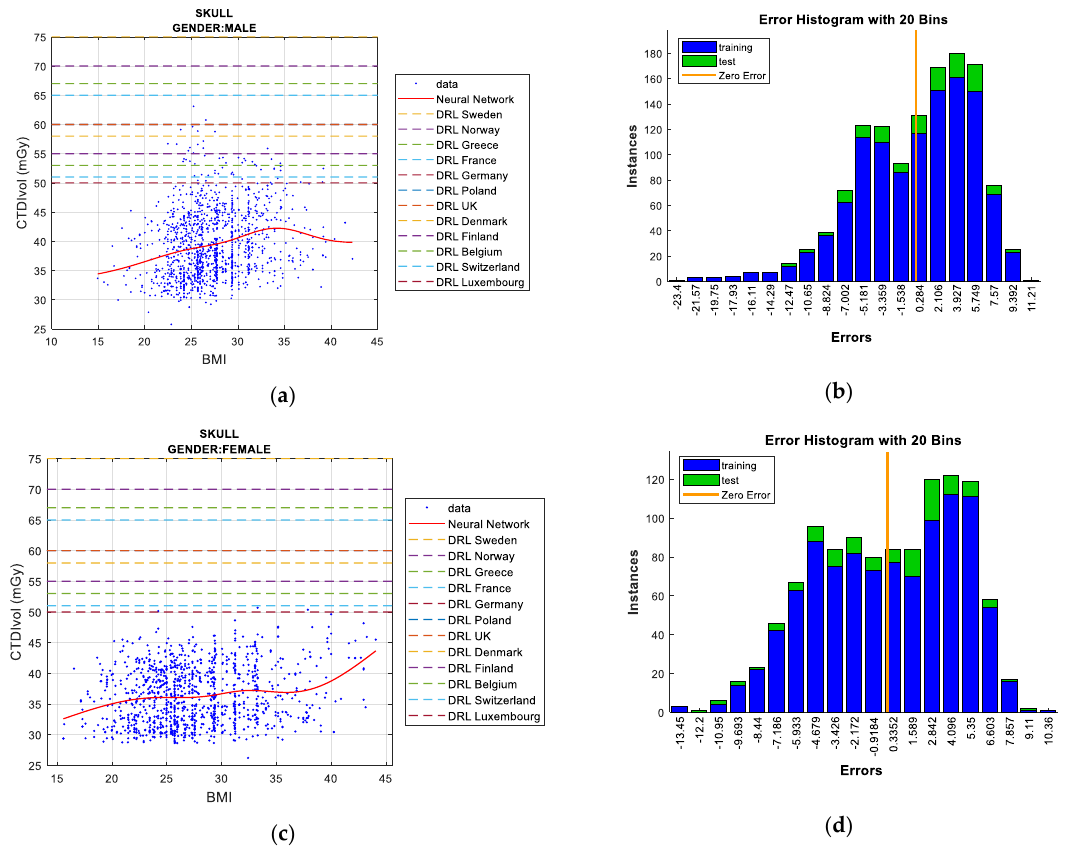
Figure 5. Radiation delivered by the scanner (CTDI VOL ) prediction according to BMI including European DRLs for men’s / women’s skull protocol ( left ), together with error histograms ( right ), employing the Neural Networks technique: men ( a , b ), and women ( c , d ).